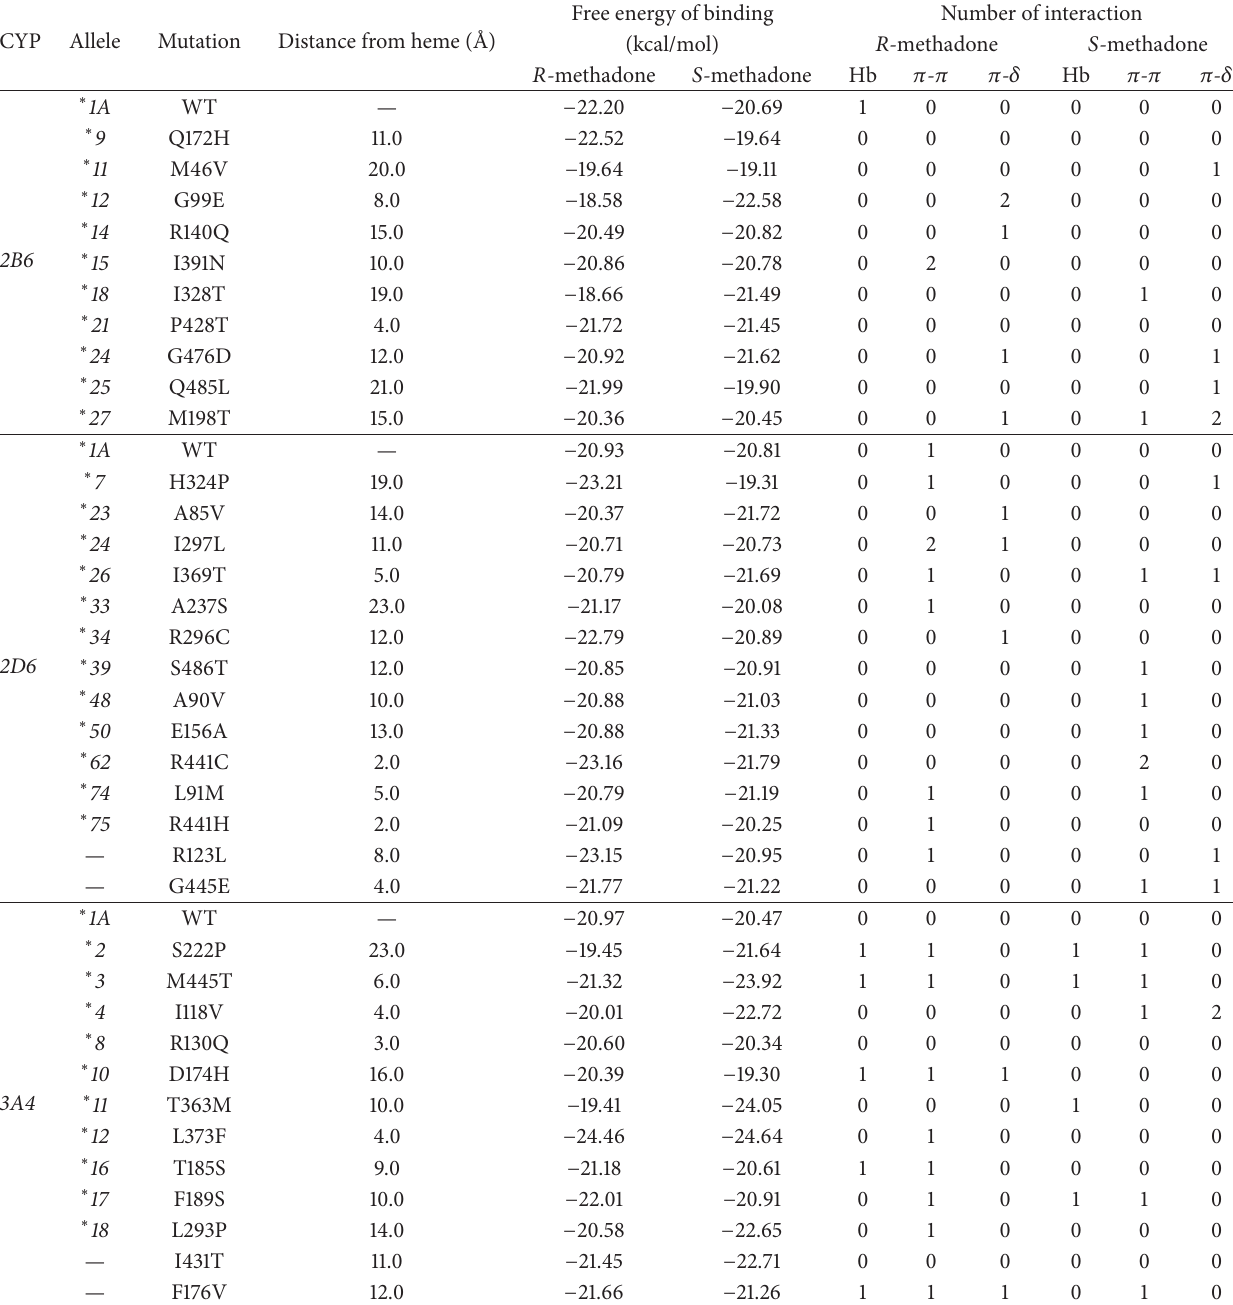
Table 2: Estimated free energy of binding (FEB) and the number of interactions in CYPs alleles from the docking simulation of R - and S